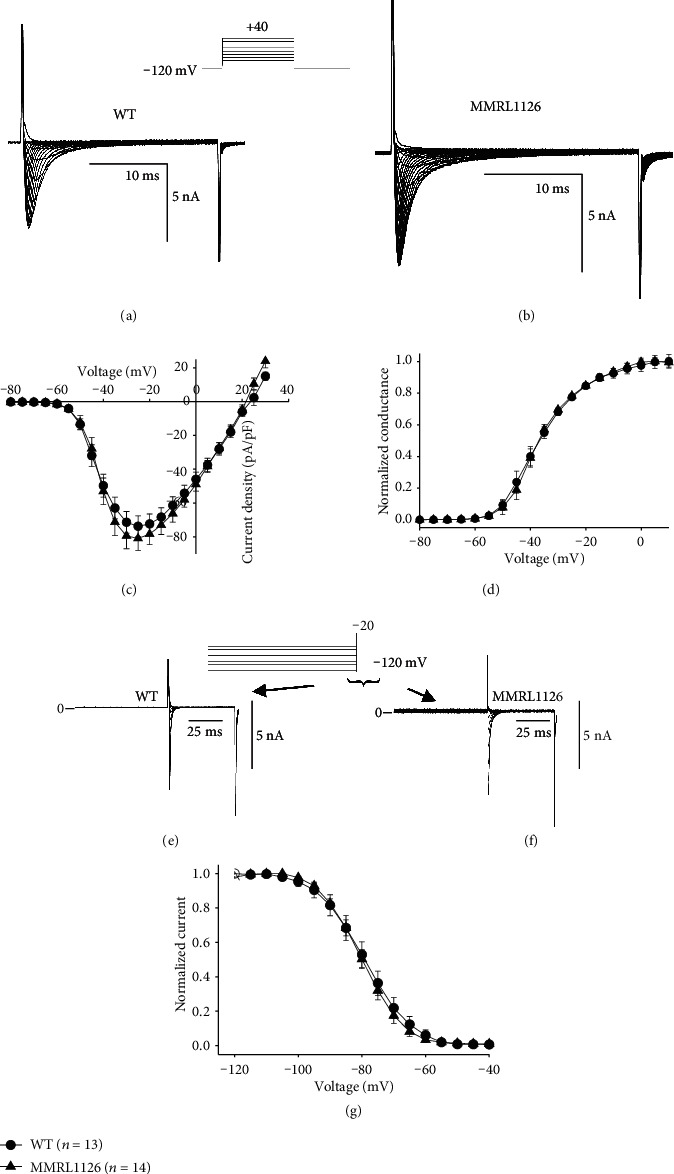
Representative INa recordings from a WT (a) and MMRL1126 hiPSC-CM (b). Current recordings were obtained at test potentials between −80 and 25 mV in 5 mV increments. The holding potential was −120 mV. (c) I–V relation for WT (n = 13) and MMRL1126 (n = 14) showing no difference in INa magnitude. (d) Steady-state activation relation for WT and MMRL1126 hiPSC-CM cells. Chord conductance was determined using the ratio of current to the electromotive potential for the cells shown in (a) and (b). Data were normalized and plotted against their test potential. Representative steady-state inactivation recordings from a WT (e) and MMRL1126 hiPSC-CM (f). The voltage clamp protocol is shown at the top of the figure. Peak current was normalized to their respective maximum values and plotted against the conditioning potential. The mean data for the steady-state inactivation relation is shown (g).